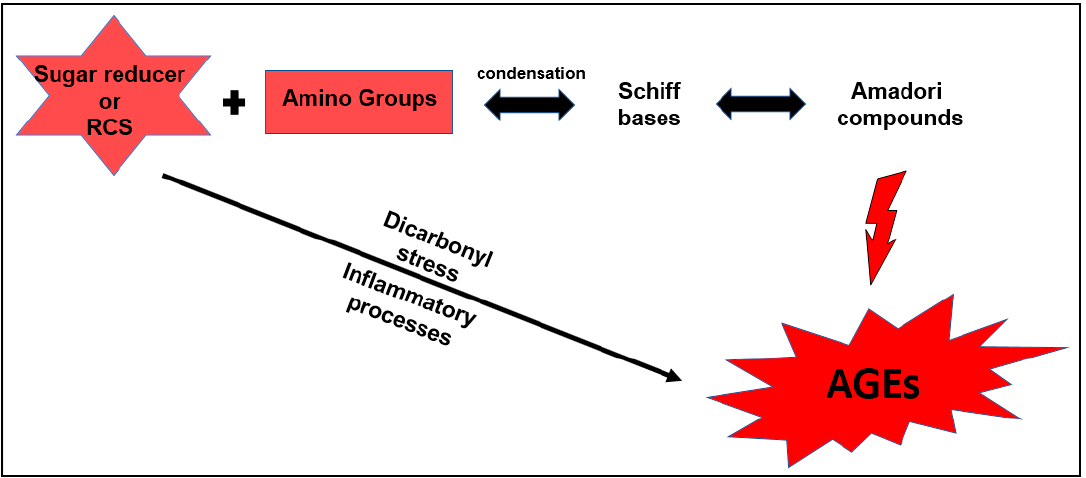
Figure 1. Schematic simplification for the formation of advanced glycation end products (AGEs). RCS: reactive carbonyl species.